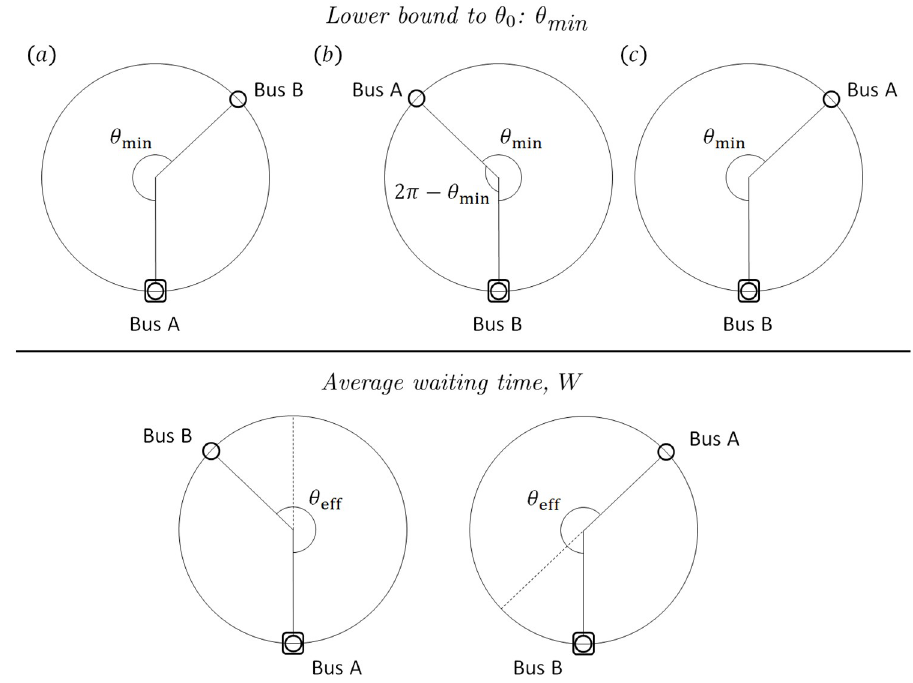
Fig 2. N = 2 buses serving M = 1 bus stop in a loop. The buses travel clockwise, and implement the no-boarding policy if Δ θ > θ 0 . Top panel: Shown here is the situation where θ 0 is the lower bound θ min , before the system is picking up people slower than people arriving at the bus stops. Bottom panel: In steady state, the phase difference Δ θ ( t ) fluctuates around the effective angle θ eff , which is bounded by θ 0 (i.e. θ eff < θ 0 ). On average, bus A and bus B would stop over the same duration τ and pick up the same number of people L . Since bus B is lagging due to its large phase difference with respect to bus A, a portion of (1 − π / θ eff ) × 100% of the people waiting for bus B would have to wait longer to board bus A instead, because bus B would have implemented the no-boarding policy when Δ θ > θ 0 . Hence if θ eff is closer to π , then fewer people would have to be denied boarding by bus B. A closer-to-antipodal configuration would improve the overall average waiting time, given by Eq